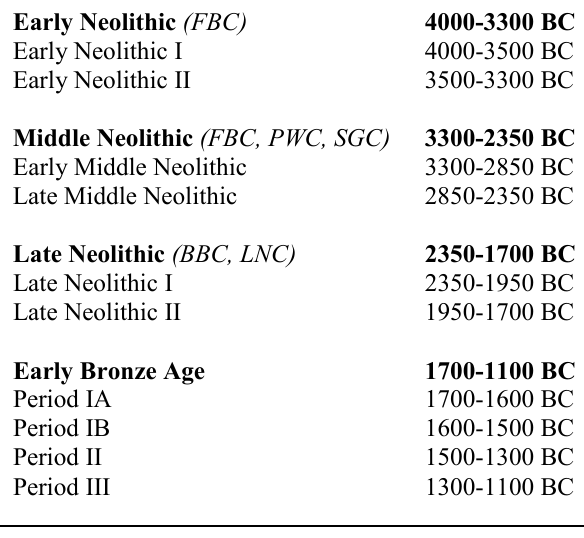
Figure 1. General Neolithic and Early Bronze Age chronology of southern Scandinavia. Abbreviations: FBC: Funnel Beaker culture, PWC: Pitted Ware culture, SGC: Single Grave culture, BBC: Bell Beaker culture, LNC: Late Neolithic culture. Dates given in calendar years